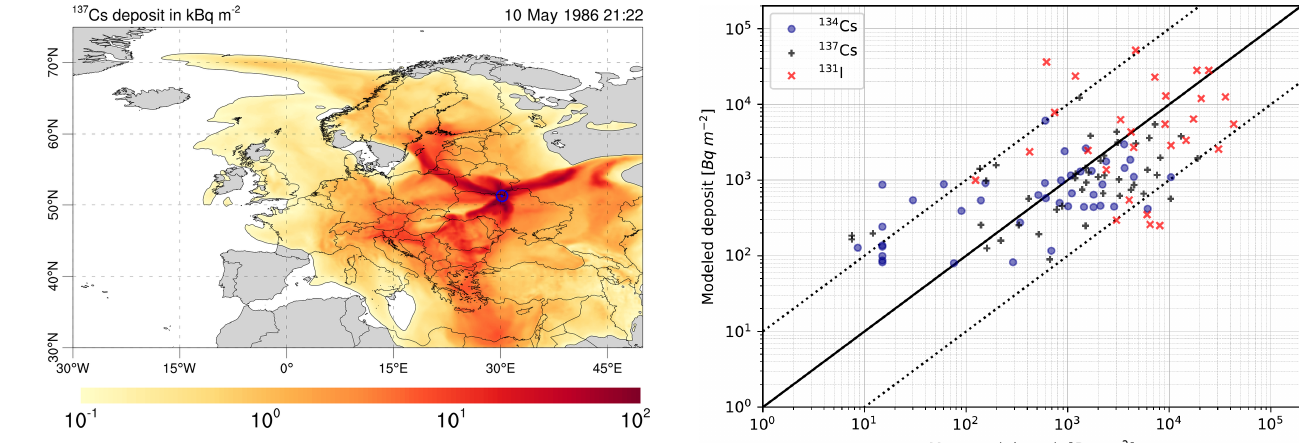
Figure 8. Chernobyl-1986 accumulated total deposition of 137 Cs on 10 May 1986. The underlying map is reported just for reference and could contain nations’ borders that are under dispute.